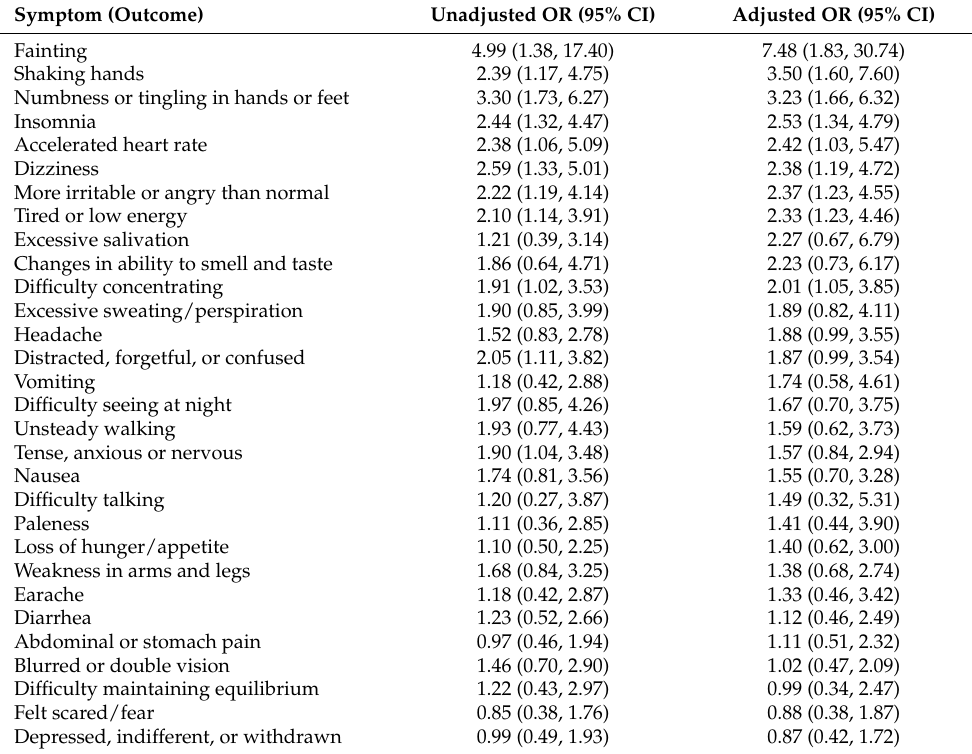
Table 2. Frequency of neurological symptoms in the last 12 months associated with having experi- enced at least one APP (predictor) in male farmers ( n = 273) in an ordinal logistic regression model. Symptom frequency was rated on a scale from 0 (never) to 4 (more than once a week). Odds ratios (OR) and their associated 95% confidence intervals (CI) are